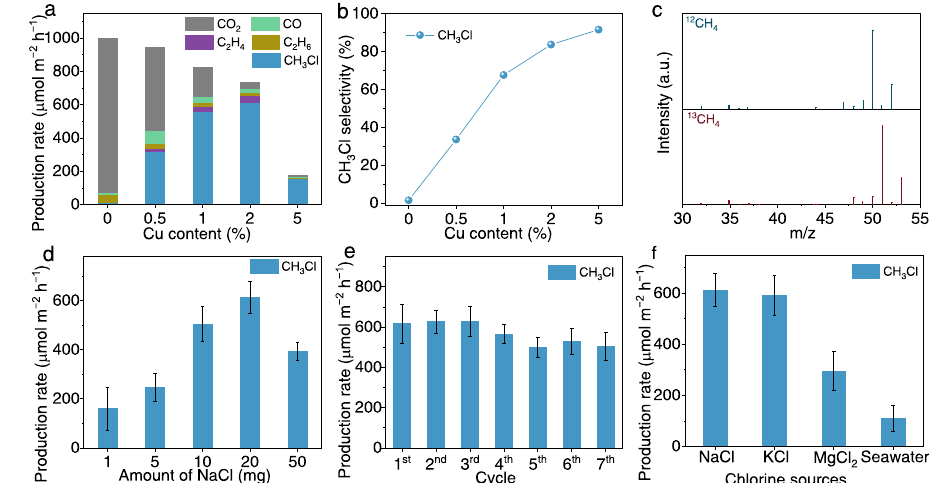
Fig. 2 | Photocatalytic halogenation of CH 4 under different conditions. a , b Photocatalytic methane halogenation ef fi ciency ( a ) and selectivity ( b ) of X % Cu – TiO 2 towardCH 3 Clproduction. c Massspectraof 12 CH 3 Cl( m/z =50)and 13 CH 3 Cl ( m/z =51) produced over 2%Cu – TiO 2 via photocatalytic methane halogenation. d Production rates of CH 3 Cl via photocatalytic methane halogenation over 2%